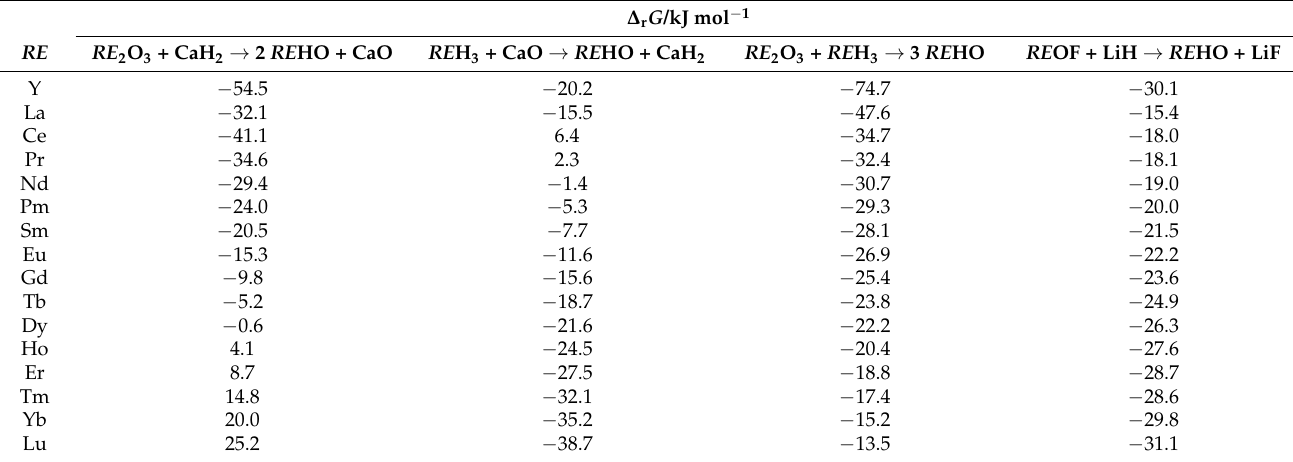
Table A6. Free reaction enthalpies ∆ r G for different synthesis approaches. Values were calculated for minimum values of E ( RE HO) among the three modifications.